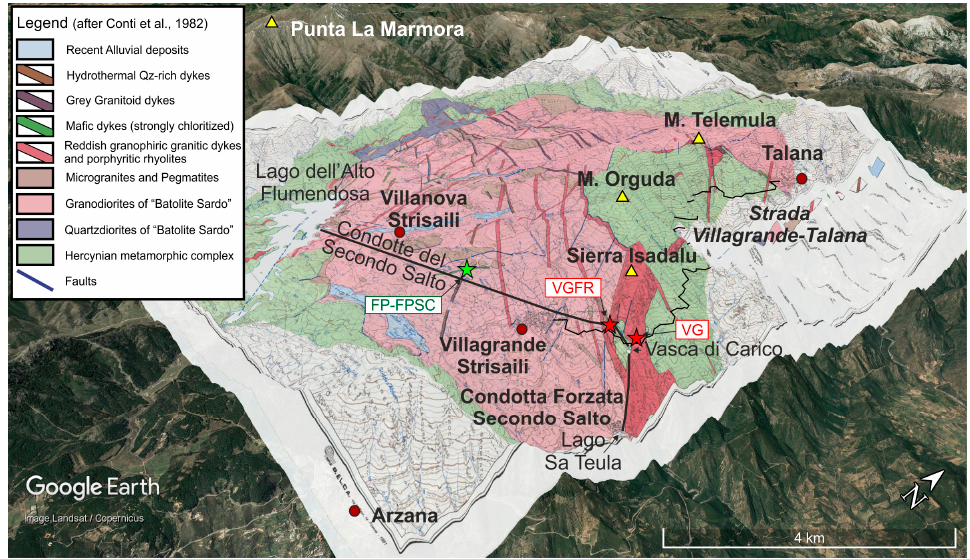
Figure 4. Local geological context. 3D-view of satellite image of Isadalu magmatic complex in Sardinia (Image Landsat/Copernicus from Google Earth Pro, Map Data, Google; courtesy of Google). The modified geological map [65] of the area is here reported after georeferentiation in Google Earth Pro (courtesy of Google). Punta La Marmora stands for Gennargentu massif. Green and red stars indicate sampling localities for mafic and granitoid rocks, respectively. Towns and main infrastructures of the Flumendosa hydroelectric plants are also shown.